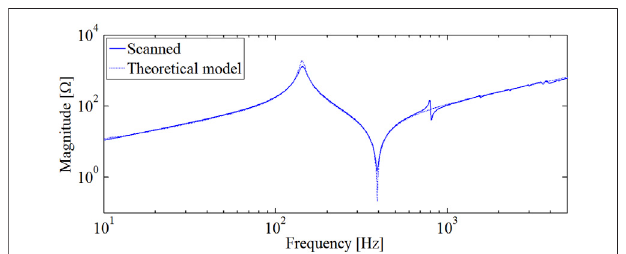
FIGURE 6 | Comparison of the scanned impedance and theoretical model of Z ca